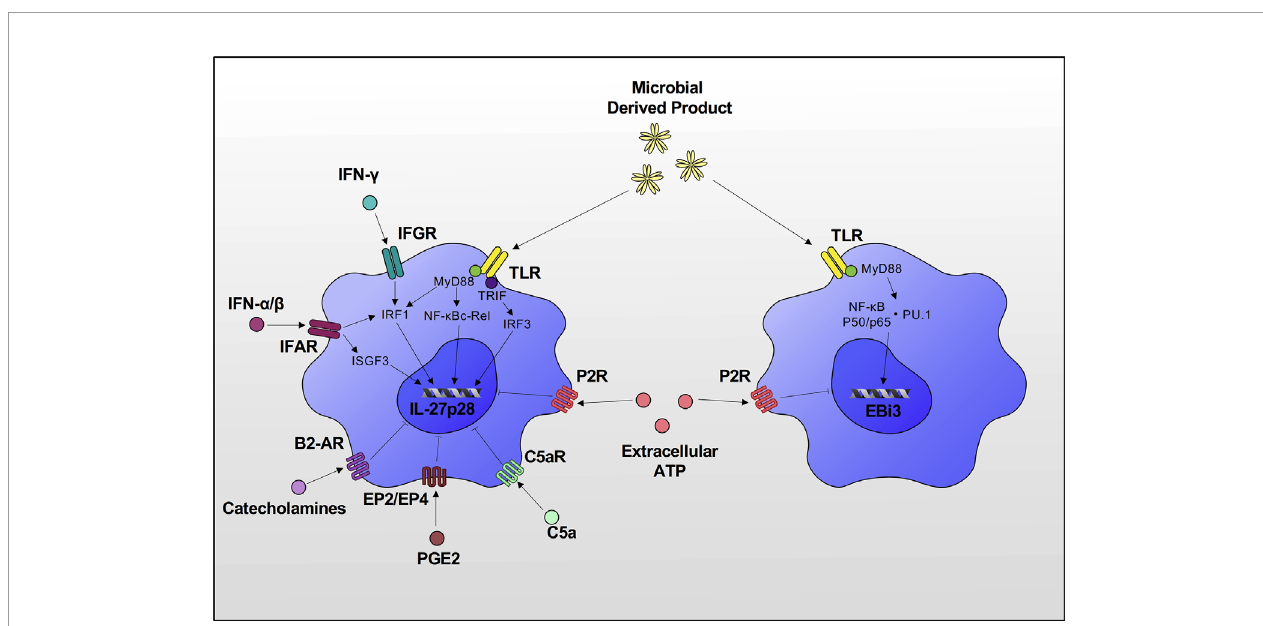
FIGURE 2 | Induction of IL-27p28 & EBI3 expression. TLR stimulation increases expression of IL-27p28 through MyD88/NF- k B c-Rel, MyD88/IRF1 and TRIF/IRF3 signaling pathways. IFN- a / b / g also upregulates IL-27p28 expression by activating IRF1. IFN- a / b is required for sustained expression of IL-27p28 via activation of IRF1 and formation of ISGF3 complex. Upregulation of EBI3 is also induced by TLR stimulation via activation of NF- k B p50/p65 and PU.1. There are also several inhibitors of IL-27 production. C5a, PGE2 and catecholamines inhibit IL-27p28 expression, and extracellular ATP inhibits both IL-27p28 and EBI3 expression via P2 receptor